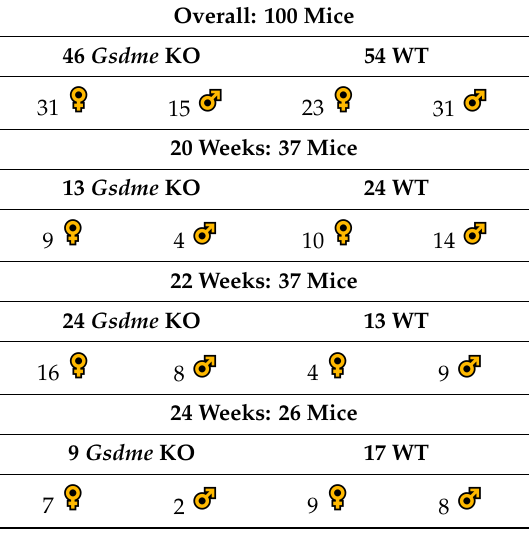
Table 2. The number of mice per timepoint, with genotype and sex, used in the AOM-induced cancer mouse model experiment.